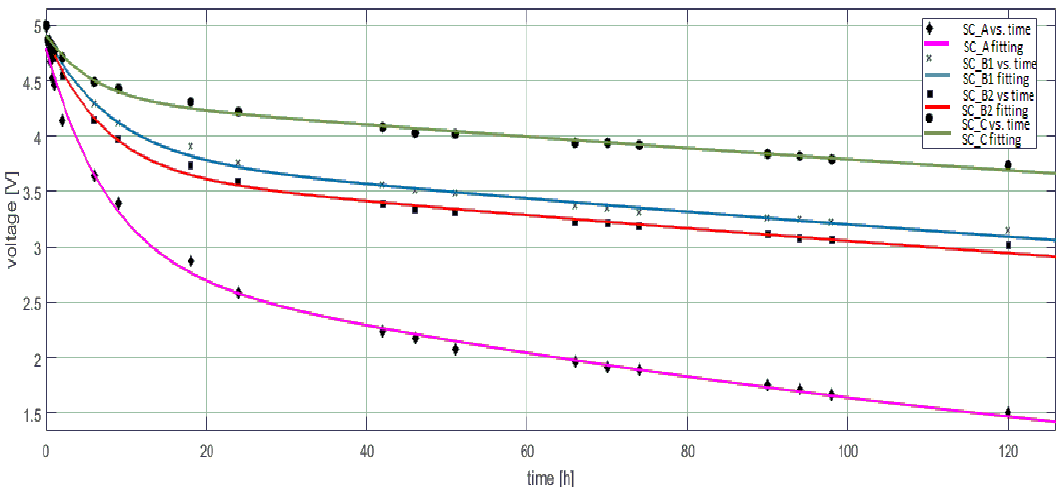
Figure 10. Exponential fitting functions determined in order to approximate the self-discharge voltage values acquired for tested SCs, kept in charge at 5 V for 1 h. Table 5. Table with the parameters of the exponential fitting functions for the SCs kept in charge at 5 V for 1 h; the determination coefficient (R 2 ) and root mean square error (RMSE) are also reported.